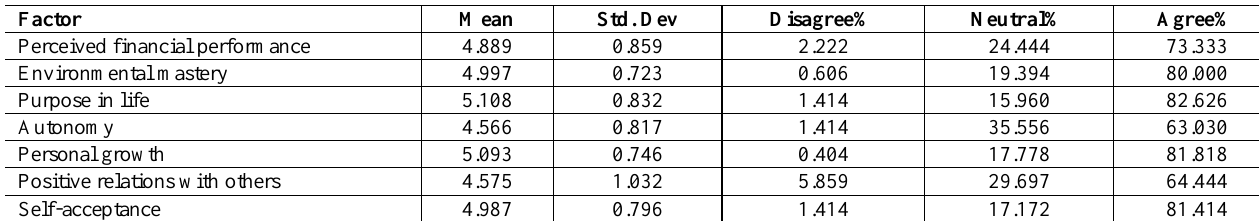
Table 4: Descriptive statistics (N = 495)